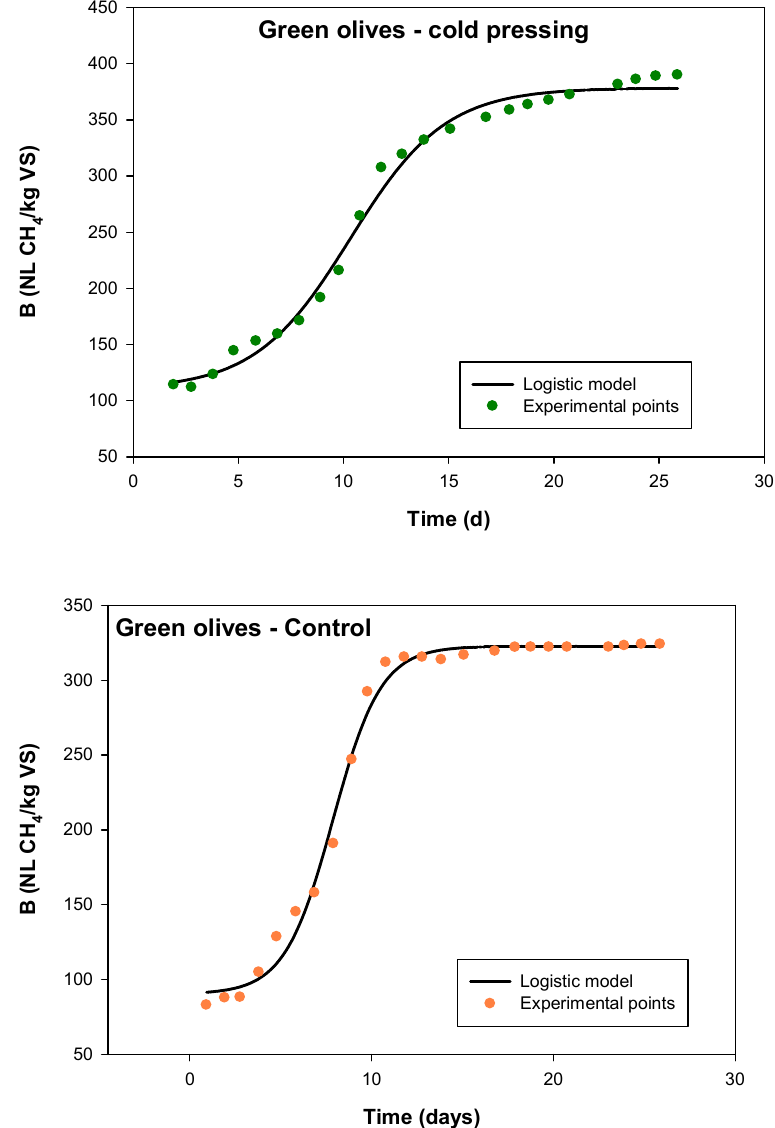
Figure 2. Variation in the experimental values for methane production and the theoretical values obtained from the logistic model (solid lines) for the residues derived from the cold-pressed green olives and the control.